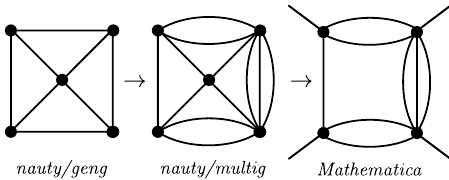
Figure 21: Simple vacuum bubbles are generated using nauty / geng (left). Single lines are then replaced by bubbles in all possible ways using nauty / multig (center). Removal of quartic vertices (using Mathematica ) leads to graphs with 4 external legs (right).